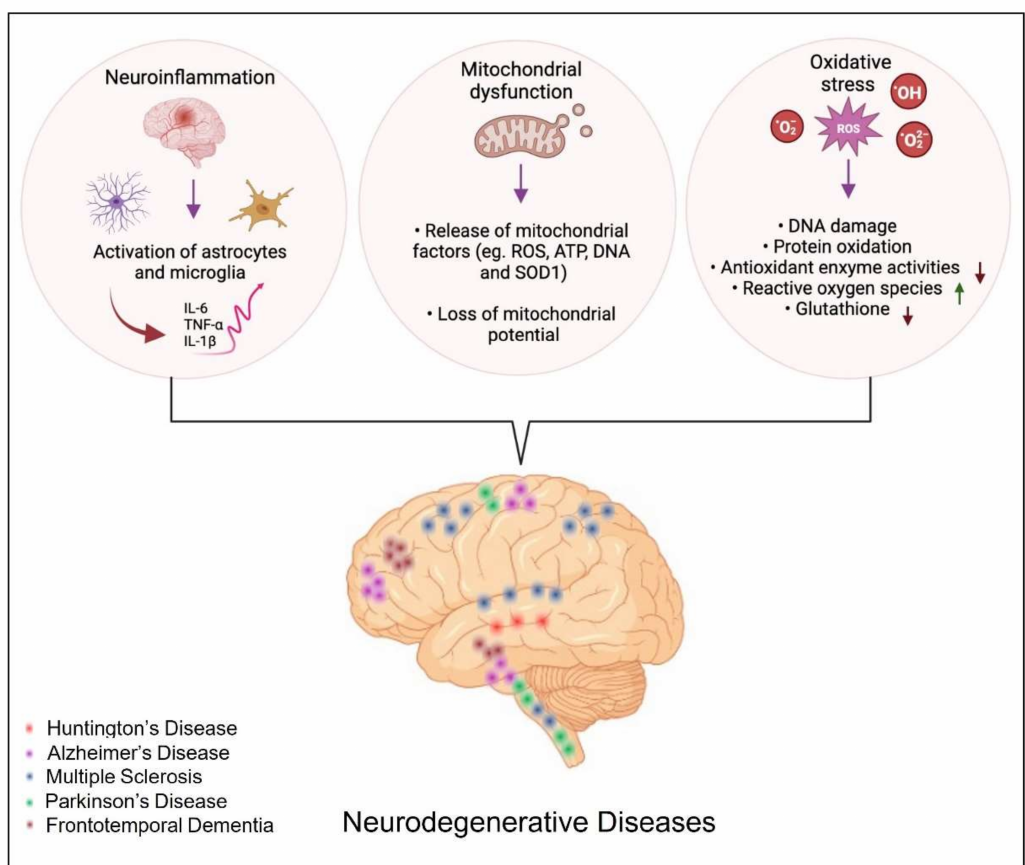
Figure 2. The different biological processes involved in the development of neurodegenerative diseases. Activated CD4 + T cells release multiple inflammatory factors, such as the Fas